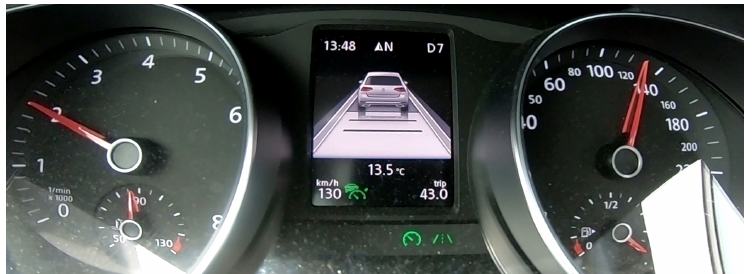
Figure 1. Example VW HMI